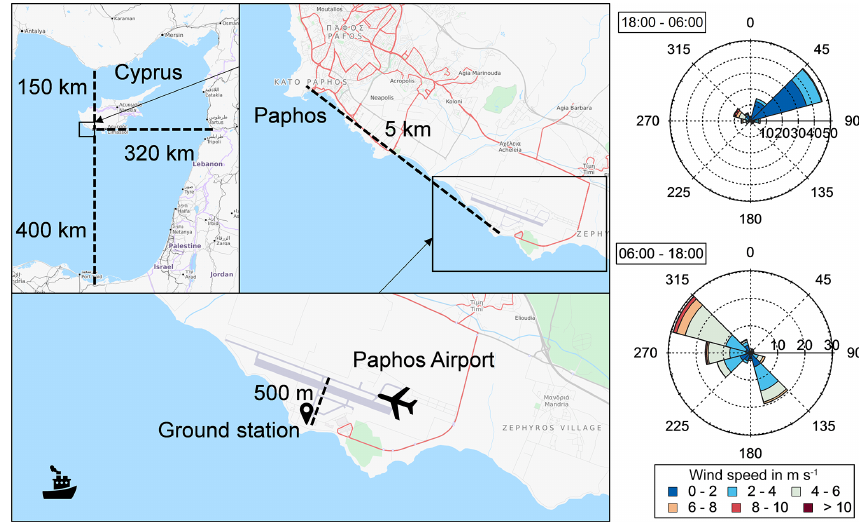
Figure 1. The island of Cyprus is located in the eastern Mediterranean Sea. Paphos is situated 150km from the Turkish coast, 320km from Syria and Lebanon, and 400km from Egypt. The measurement station was located at the coastline at Paphos International Airport, which is 5km southeast from Paphos city centre. The runway of the Paphos airport is at a distance of approximately 500m northeast from the measurement station. The wind roses in the right panel show the wind frequency distribution during the measurement period, 3–30 April 2017. The local land–sea breeze system dominates the local wind pattern. During night-time (18:00–06:00UTC), the wind is primarily northeast at 1min averaged low wind speed between 0.5 and 4ms − 1 . The sea breeze during daytime (06:00–18:00UTC) is mostly southeast or northwest with the highest wind speeds. Wind roses were plotted using the Zefir tool (Petit et al., 2017), and the map is from OpenStreetMap (© OpenStreetMap contributors 2019; distributed under a Creative Commons BY-SA